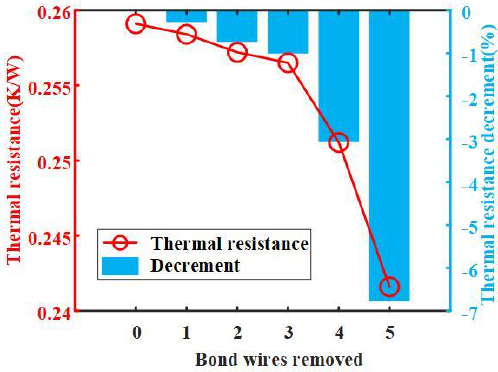
Figure 10. Measured thermal resistance using module’s power dissipation.